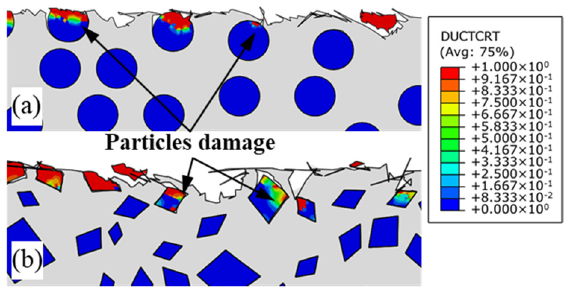
Figure 16. Particle damage of subsurface ( a ) circular particles; ( b ) irregular polygonal particles.